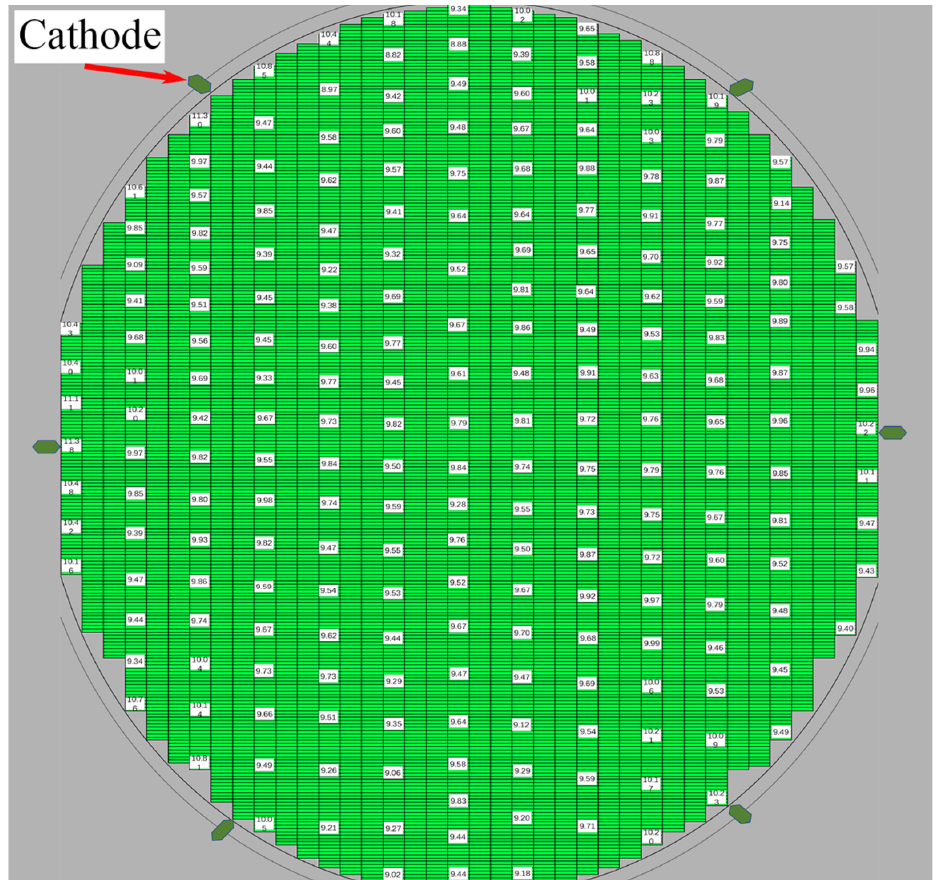
Figure 14. Au bump distribution on the whole wafer surface.